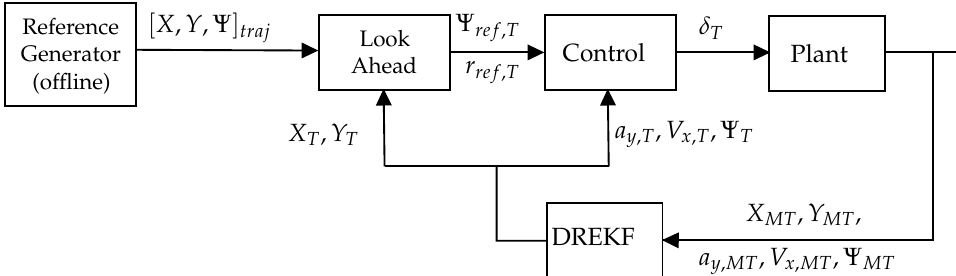
Figure 1. Proposed closed-loop control. DREKF, Dual-Rate Extended Kalman